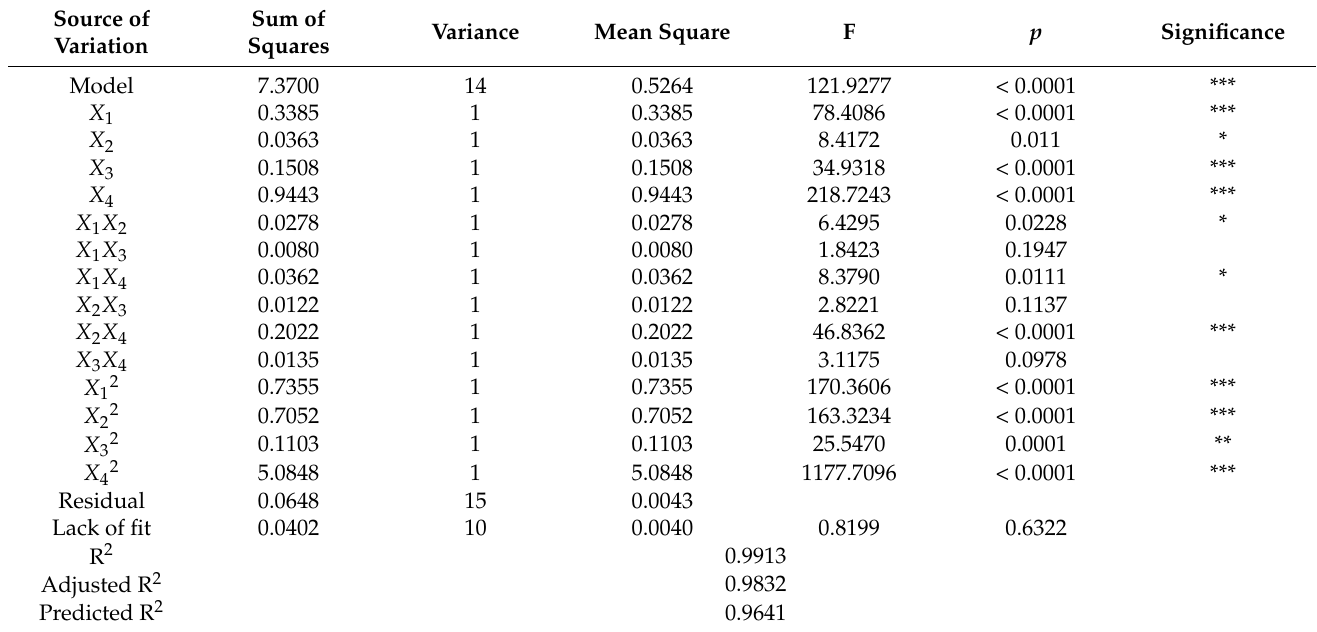
Table 3. Results of analysis of variance (ANOVA) of the Box–Behnken design